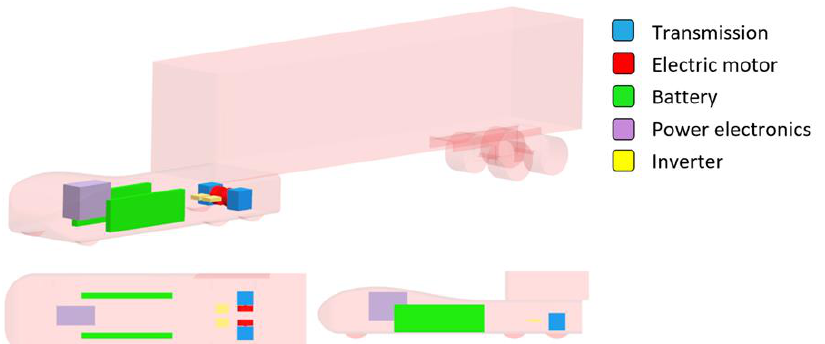
Fig. 5. Concept One schematic shown in isometric view (top), plan view (bottom left), and side view (bottom right).